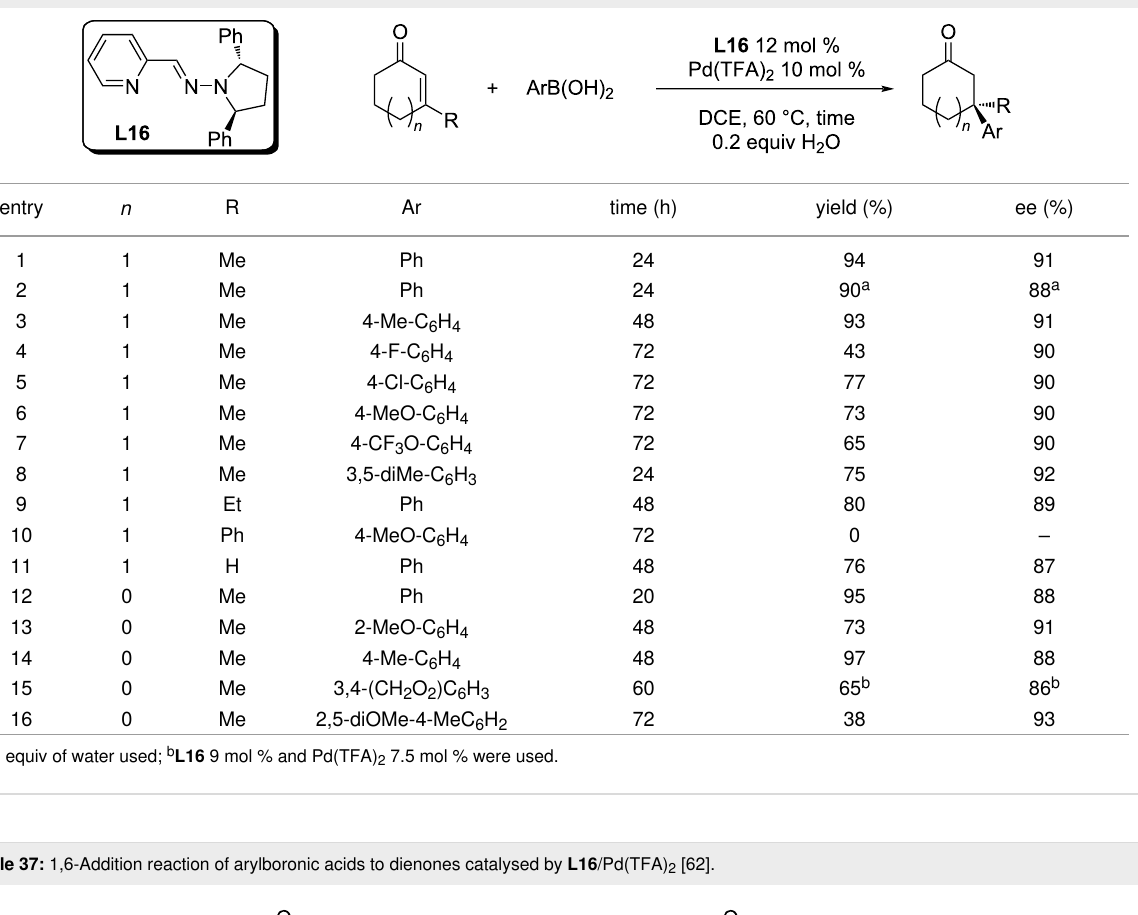
Table 36: Addition reactions of arylboronic acids to five and six-membered enones catalysed by L16 /Pd(TFA) 2 [62].